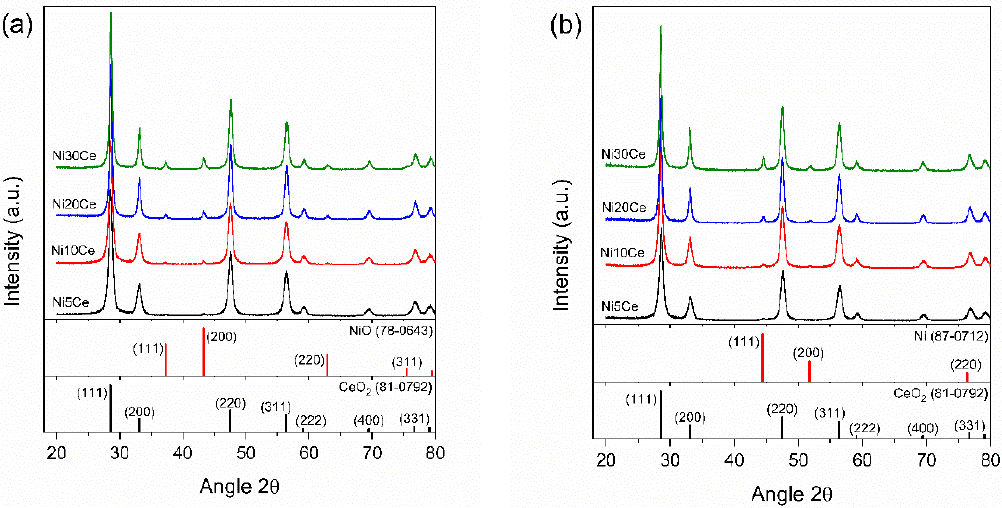
Figure 1. X-ray diffraction (XRD) patterns of NixCe catalysts: ( a ) calcined; ( b ) reduced at 500 °C. Table 1. Chemical composition, textural properties and crystallite size of catalysts.